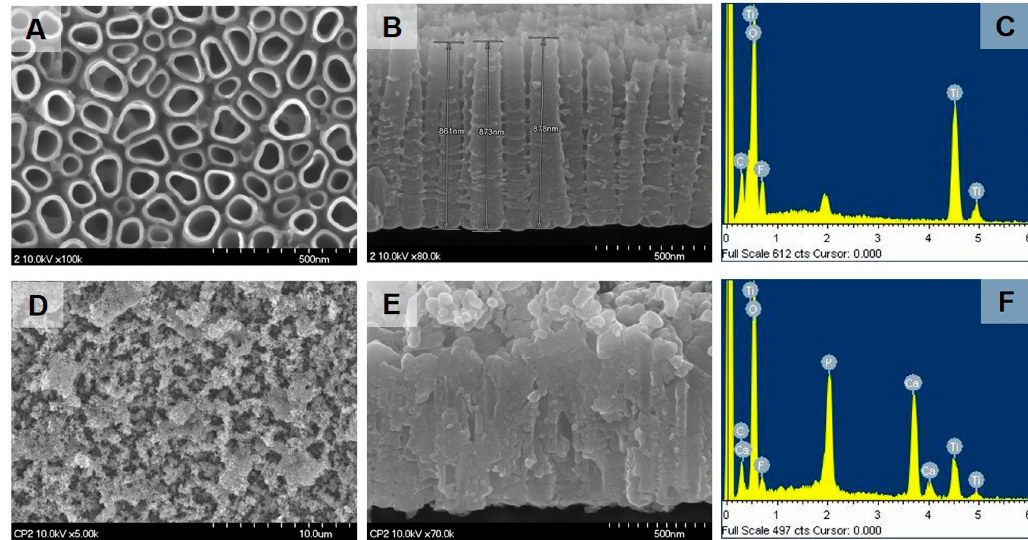
Figure 1. Field emission scanning electron microscopy (FE-SEM) and EDS analysis of the nanotube layer ( A – C ) and precalcified nanotube layer ( D – F ) on a Ti mesh.